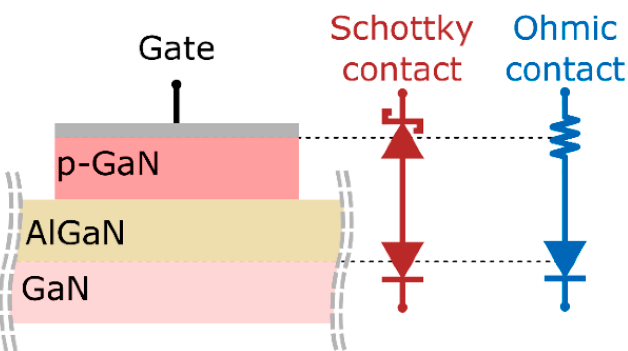
Figure 4. An ideal depiction of the cross-section of the gate heterostructure in p-GaN Gate HEMT. Reprinted with permission from ref. [78]. Copyright 2021 MDPI.